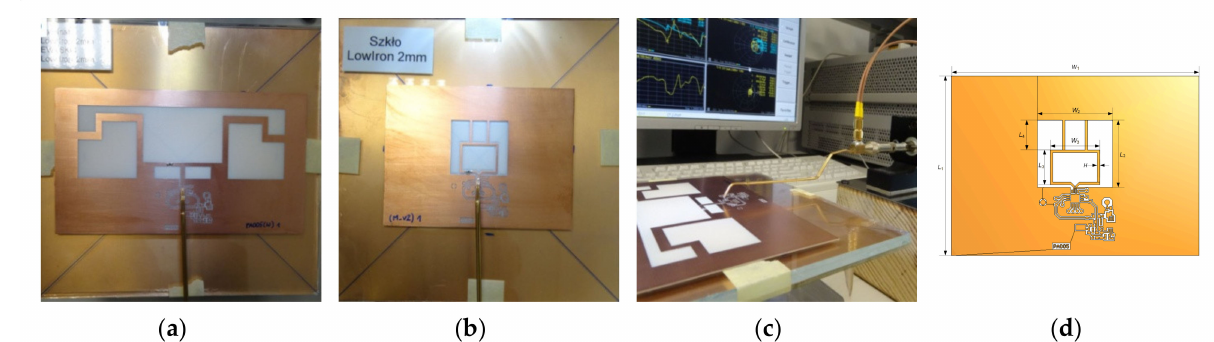
Figure 5. Designs of RFID antenna with short-circuited arms: ( a ) Design #A1; ( b ) Design #A2; ( c ) Sample under tests; ( d ) Numerical model of #A2 design ( L x , W x , H —dimensions).